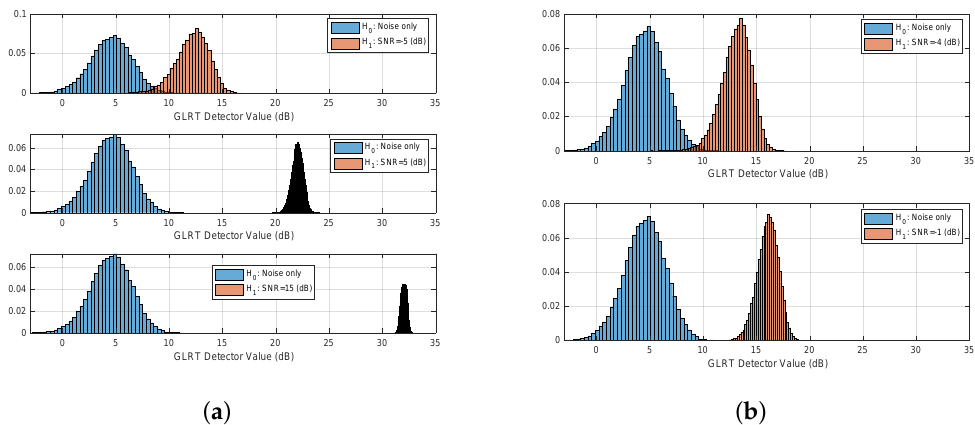
Figure 2. Histograms of the detector value for both hypotheses and various SNRs. ( a ) SNR = − 5, + 5, + 15 dB. ( b ) SNR = − 4, − 1